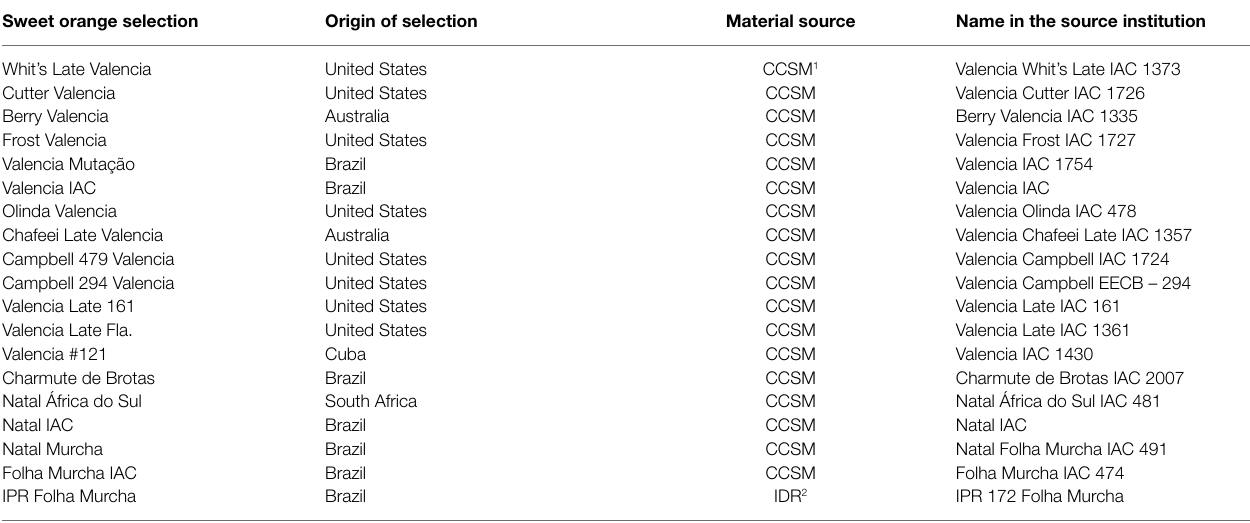
TABLE 1 | Origin of the 19 selections of sweet orange ( Citrus × sinensis ) assessed in this study. Sweet orange selection